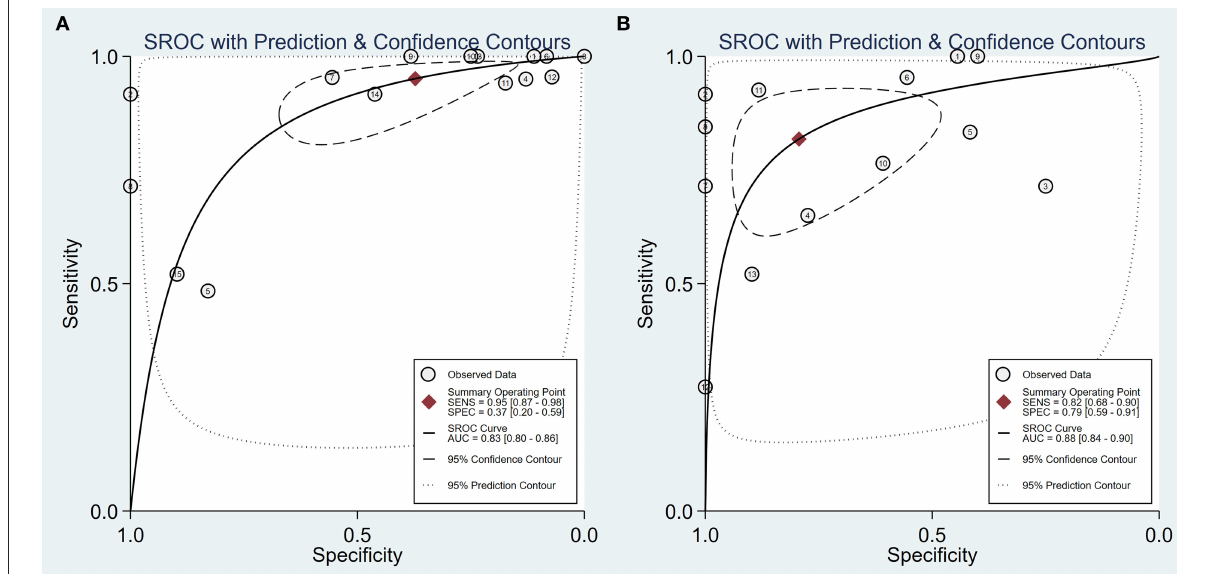
FIGURE4 The hierarchical summary receiver operating characteristic curve. (A) An HSROC curve of intraoperative BAEP changed group; (B) HSROC curve of intraoperative BAEP lost